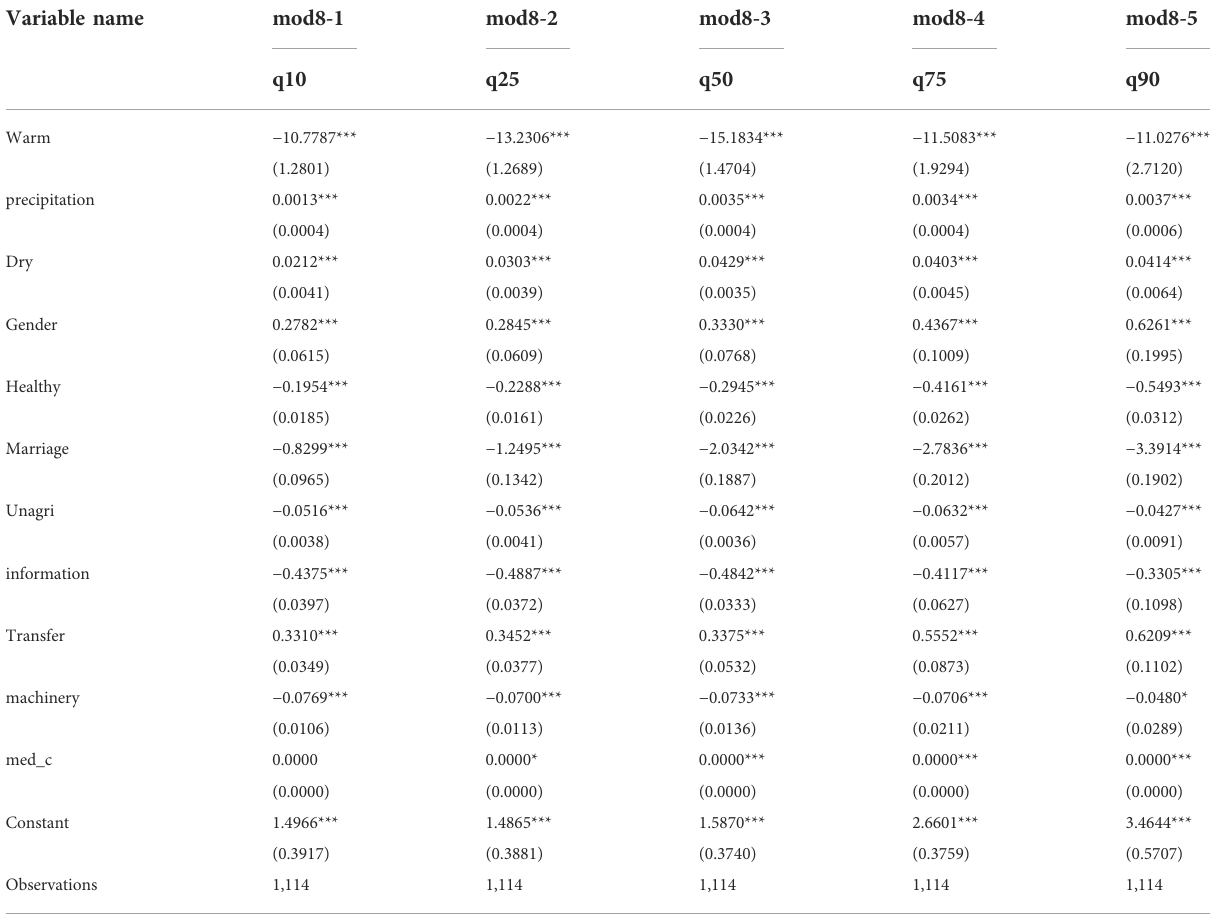
TABLE 8 Impact of extreme weather on farm households with different levels of poverty vulnerability (poor = USD